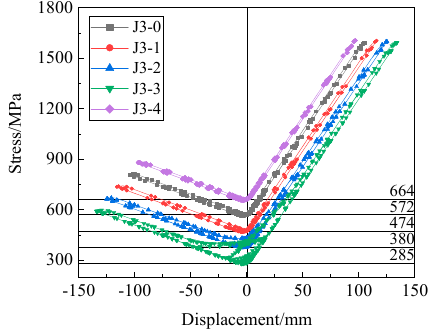
Figure 28. Stress variation curves of steel strands.